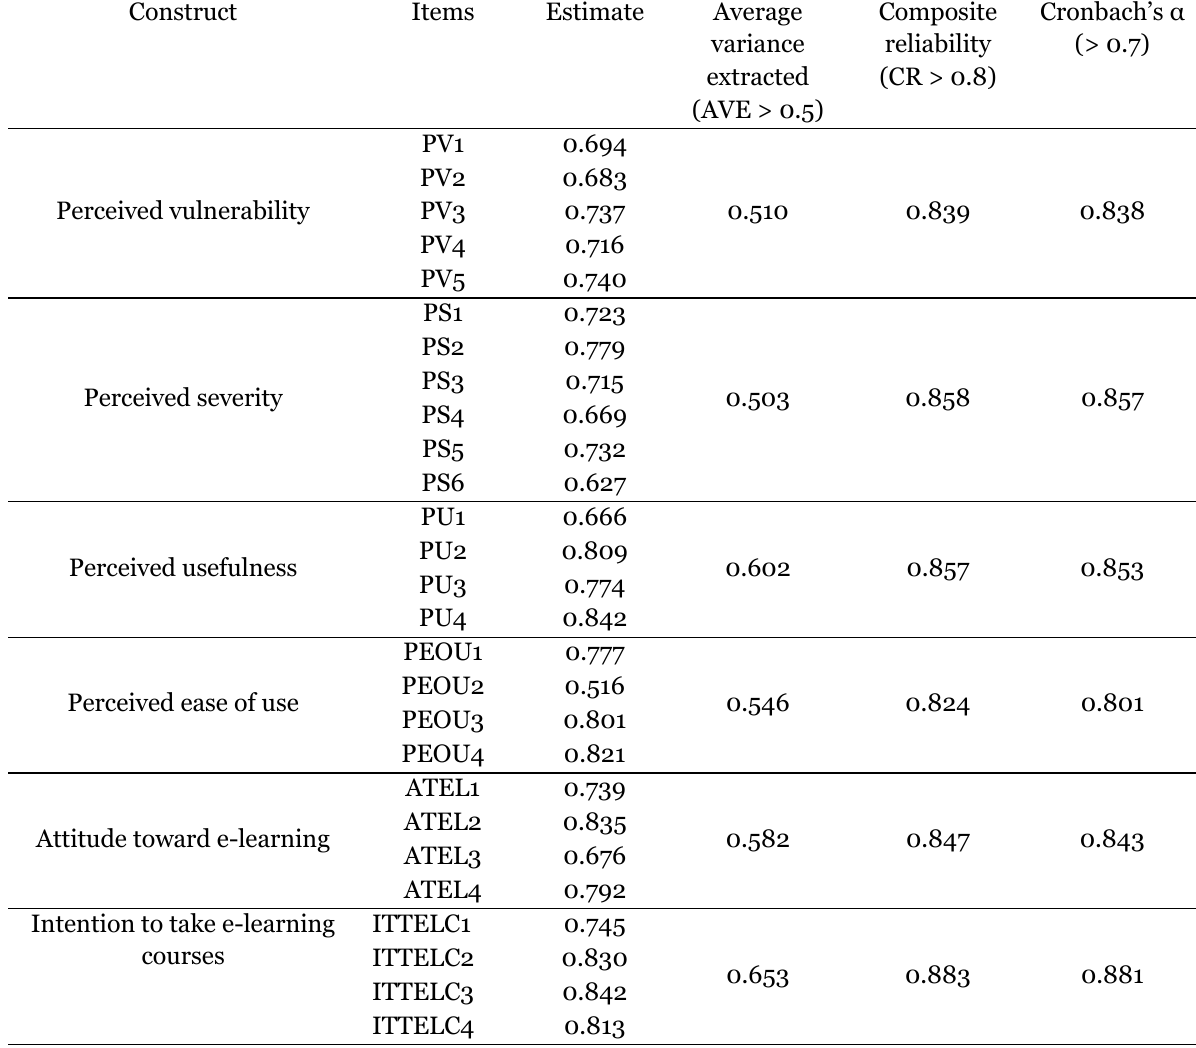
Results of Confirmatory Factor Analysis, Reliability Test, and Convergent Validity